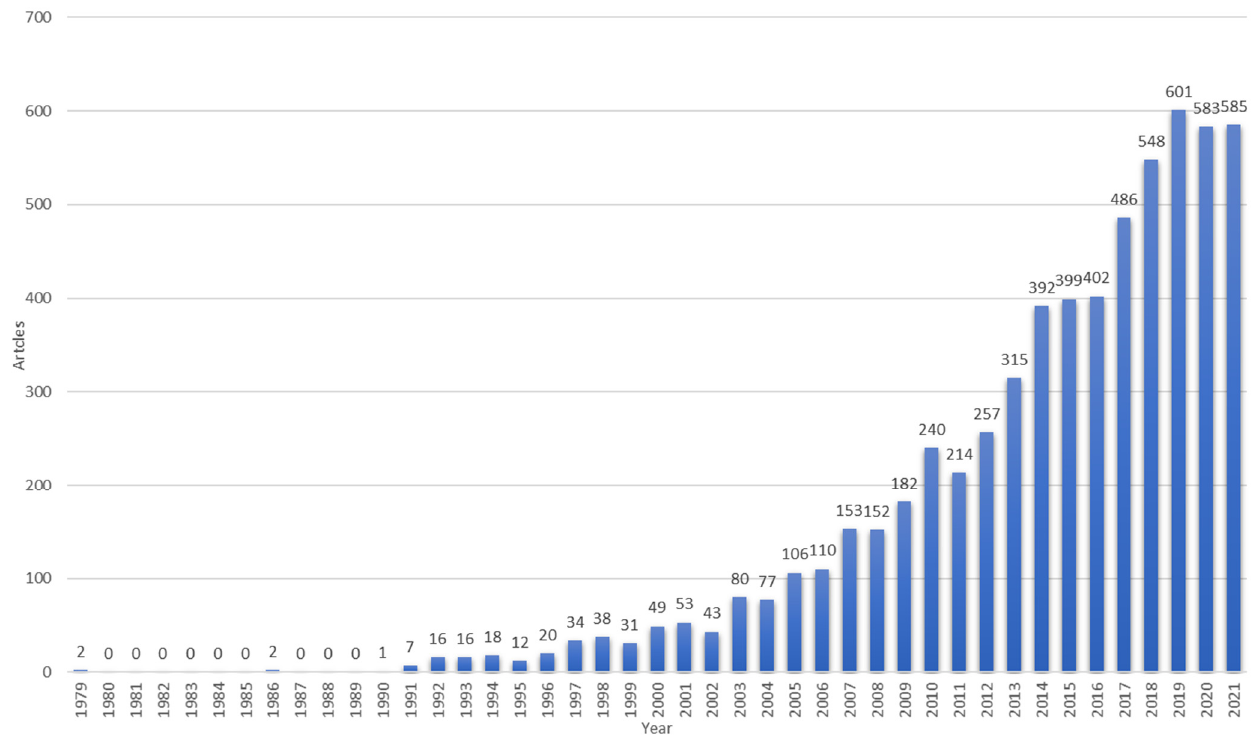
Figure 2. Annual output of urban land management studies in Web of Science from 1979 to 2021.